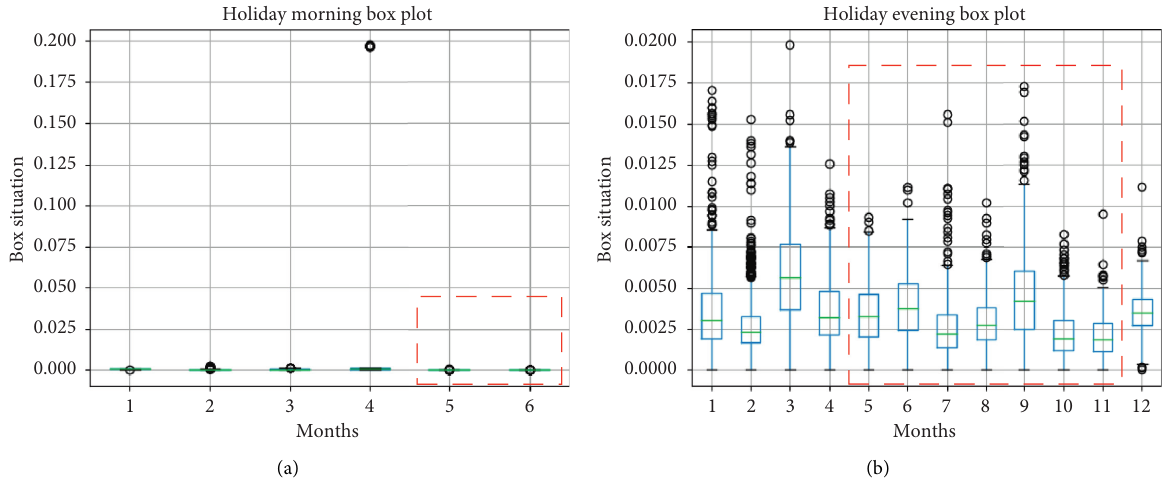
Figure 10: Box diagrams showing a different distribution of distances on vocation days in different months. The horizontal axis represents the months. The vertical axis representsthe statistical status of distances. (a) Distribution of distances in morning peak on vacation days and (b) distribution of distances in evening peak on vacation